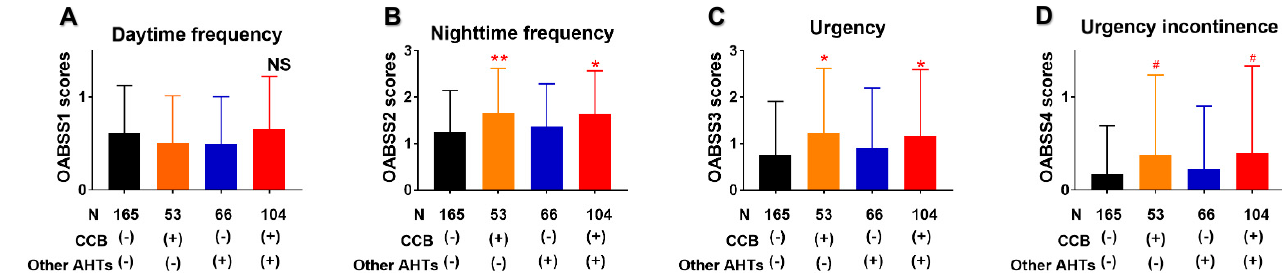
Figure 4. Comparison of respective OABSS items (( A ) daytime frequency, ( B ) night time frequency, ( C ) urgency, and ( D ) urgency incontinence) in patients taking CCB alone ( n = 53, orange columns), other AHTs ( n = 66, blue columns), and CCB plus other AHTs ( n = 104, red columns) compared to those not taking AHTs ( n = 165, black columns). Nighttime frequency ( B ), urgency ( C ), and urgency incontinence ( D ) were higher in patients taking CCB alone and CCB plus other AHTs. Patients not taking AHTs other than CCB, were comparable to those not taking any AHTs. AHT(s) antihypertensive agents, CCB calcium channel blocker, OABSS overactive bladder symptom score, NS not significant, # p < 0.1, * p < 0.05, ** p <